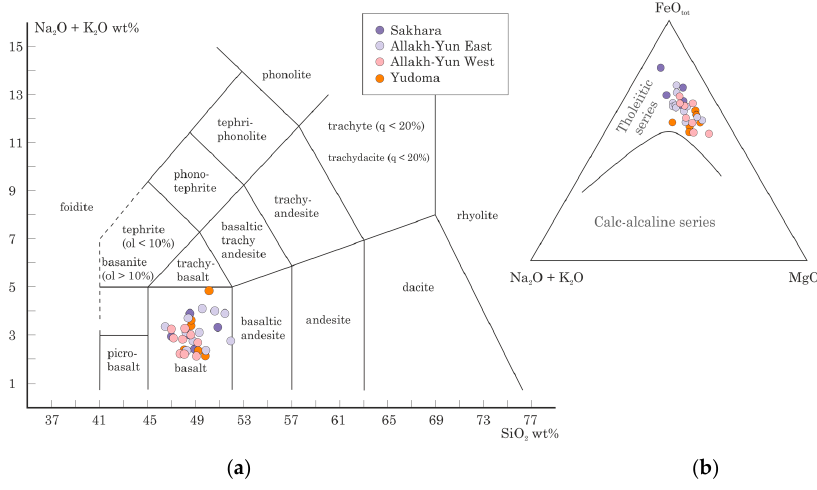
Figure 4. ( a ) Sette-Daban complex samples plotted on a total alkali-silica (TAS) diagram (after [22]). ( b ) Sette-Daban complex samples plotted on a Na 2 O + K 2 O-FeO tot -MgO discrimination diagram [23].